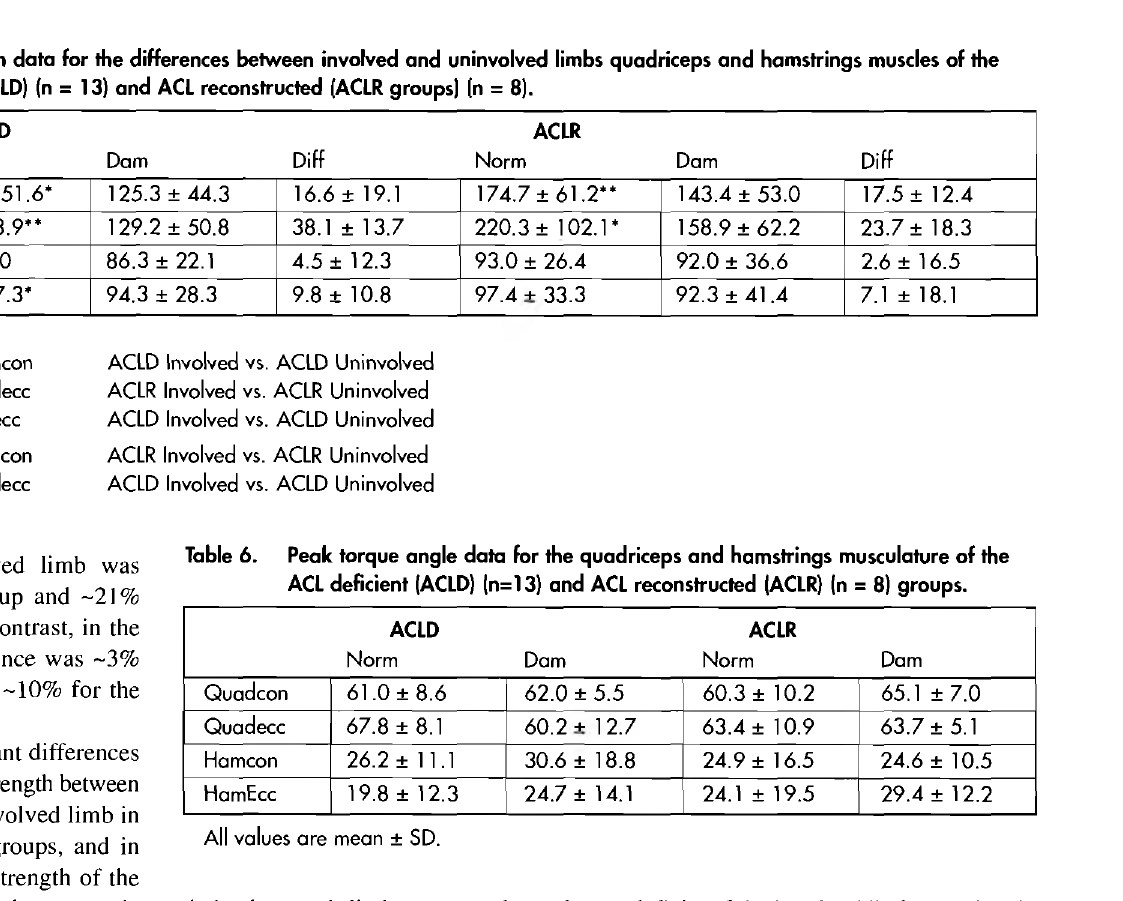
Table 5. Isokinetic strength data for the differences between involved and uninvolved limbs quadriceps and hamstrings muscles of the ACL deficient (ACLD) (n = 13) and ACL reconstructed (ACLR groups) (n = 8).